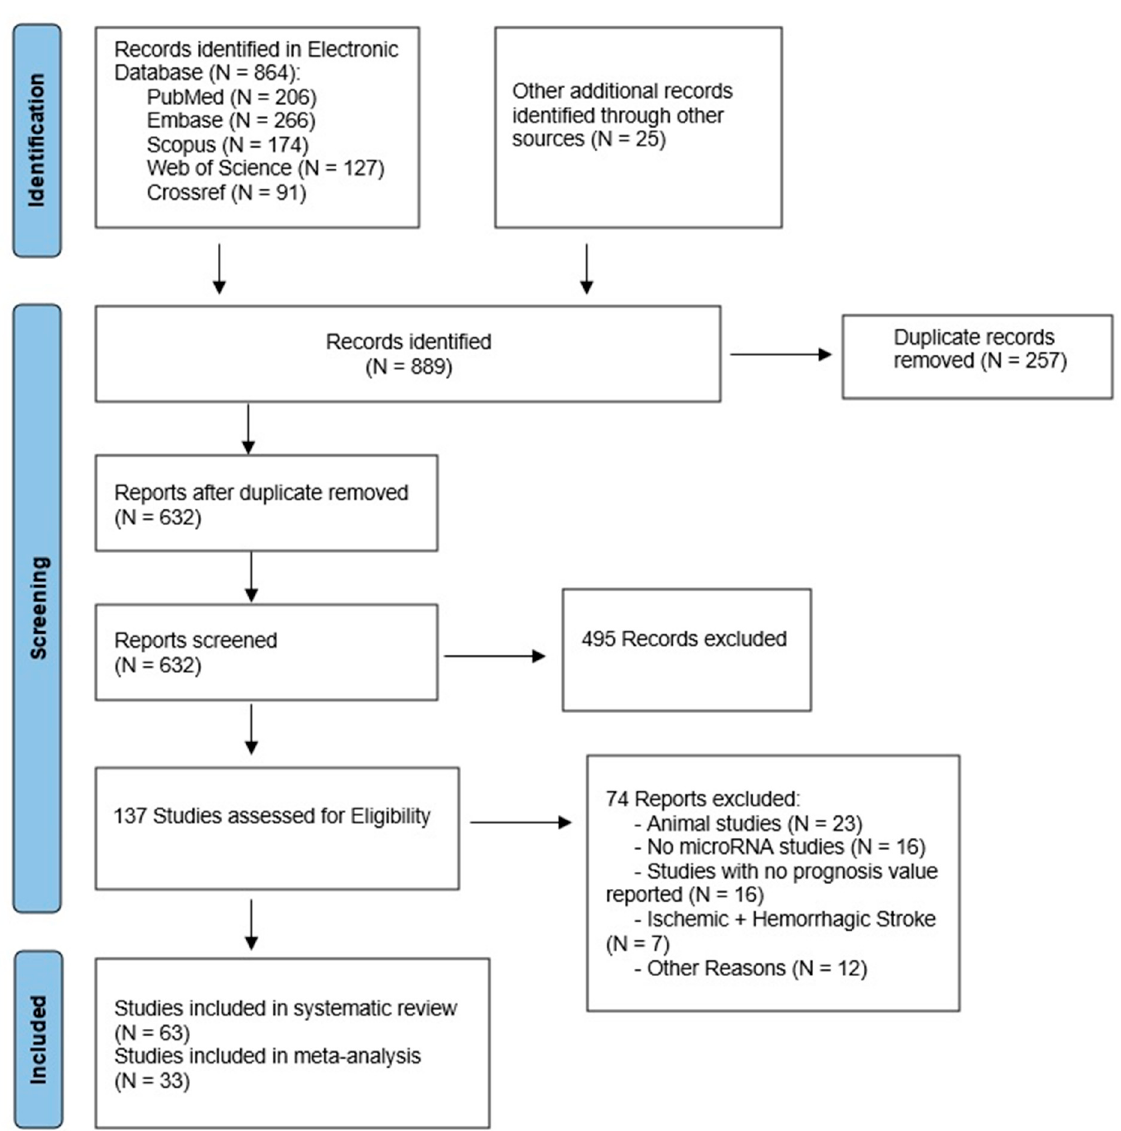
Figure 1. Flowchart with selection criteria of research studies included in review.